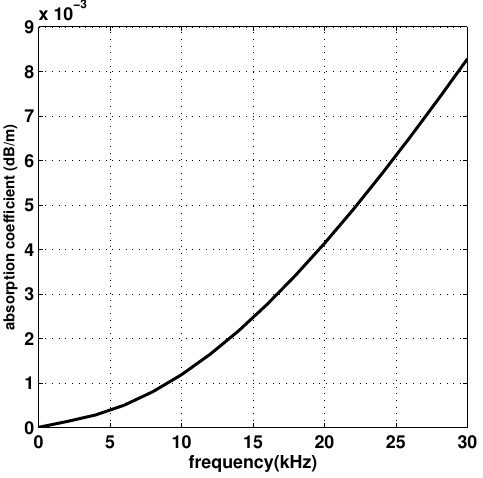
Figure 2. Absorption coefficient, α f , versus frequency.